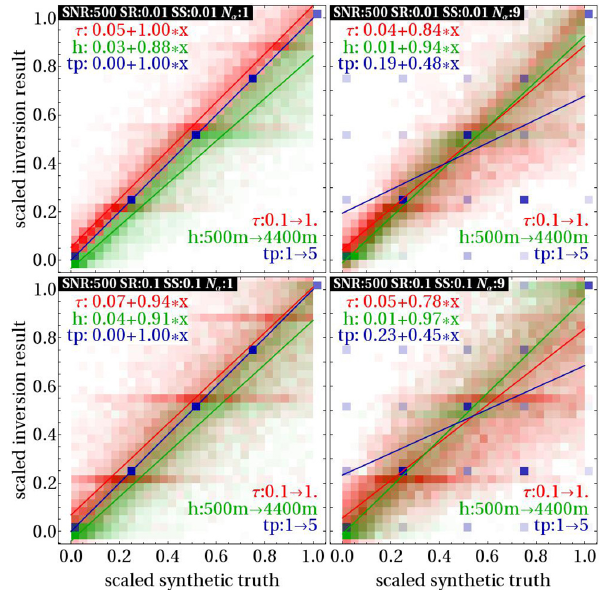
Figure 10. Similar to Fig. 9 but for a prescribed signal to noise ratio of